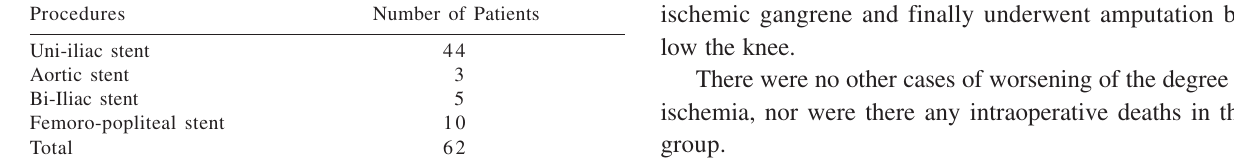
Table 1 – Procedures performed.